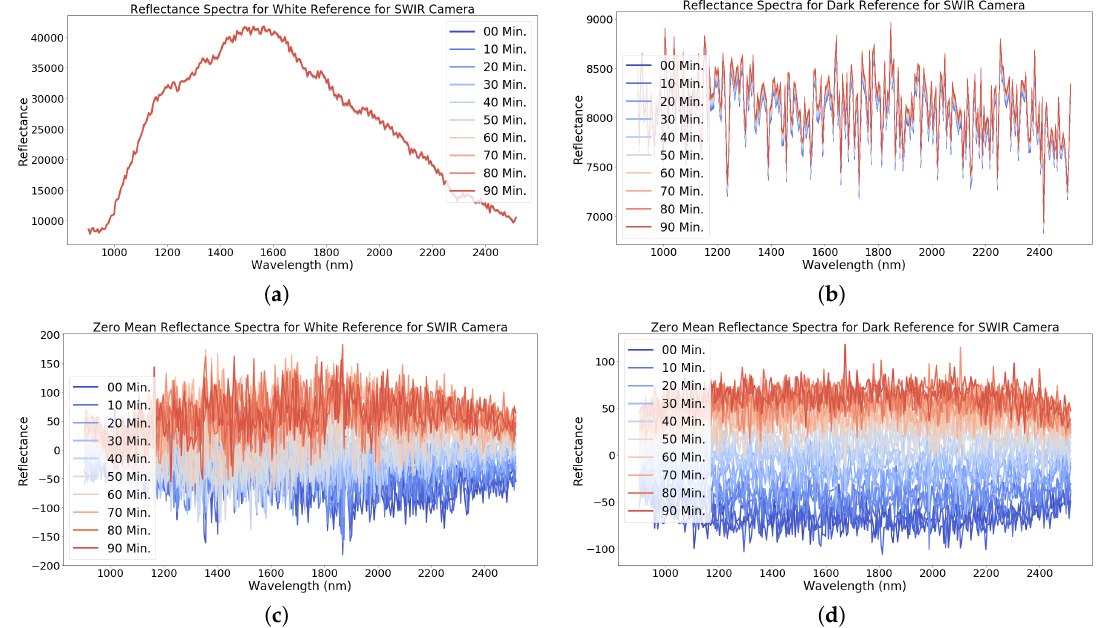
Figure 12. ( a ) White reference and ( b ) dark reference variability for a single pixel associated with the Optopolymer reference under controlled conditions for our SWIR Camera. Zero mean reflectance for the white reference ( c ) and dark reference ( d ).